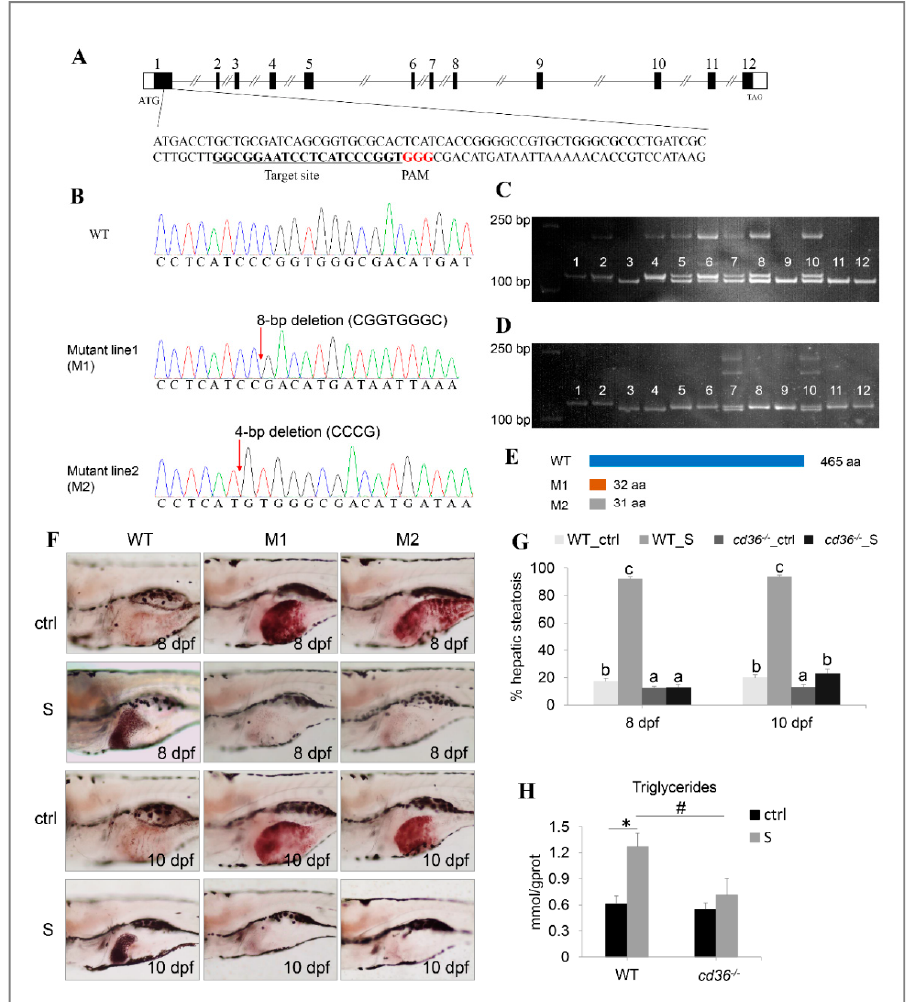
Figure 9. Establishment of the cd36 knockout zebrafish line. ( A ) Genomic structure of the zebrafish cd36 gene and CRISPR/Cas9 target site design. ( B ) DNA sequencing confirmed that two mutants (c. 86_93delCGGTGGGC, p.Pro29Argfs5) and (c. 84_87delCCCG, p. Ile28Metfs5) were generated. ( C , D ) Genotypes of cd36 mutants were screened by the PAGE technology. Image C labels the mutant line1 (M1): Lanes 3, 9, 11, and 12 were identified as cd36 homozygous mutant line; lanes 5, 6, 7, 8, and 10 were identified as cd36 heterozygous mutant line; lanes 1, 2, and 4 were identified as WT zebrafish. Image D labels the mutant line2 (M2): Lanes 3 and 4 were identified as cd36 homozygous mutant line; lanes 7 and 10 were identified as cd36 heterozygous mutant line; lanes 1, 2, 5, 6, 8, 9, 11, and 12 were identified as WT zebrafish. ( E ) A diagram representative of WT and two truncated mutant CD36 proteins (M1 and M2). ( F ) Oil Red staining of WT and cd36 -/- mutant zebrafish larvae at 8 and 10 dpf. The ORO-stained signal in intestinal lumen is the lipid droplets of exogenous nutrients. ( G ) Percentages of WT and cd36 -/- mutants (M1) with hepatic steatosis at 8 and 10 dpf. Significant differences are marked by different letters. ( H ) TAG levels in starved WT and cd36 -/- mutants (M1) at 8 dpf. # p < 0.05 compared to WT_S; * p < 0.05 compared to WT_ctrl.